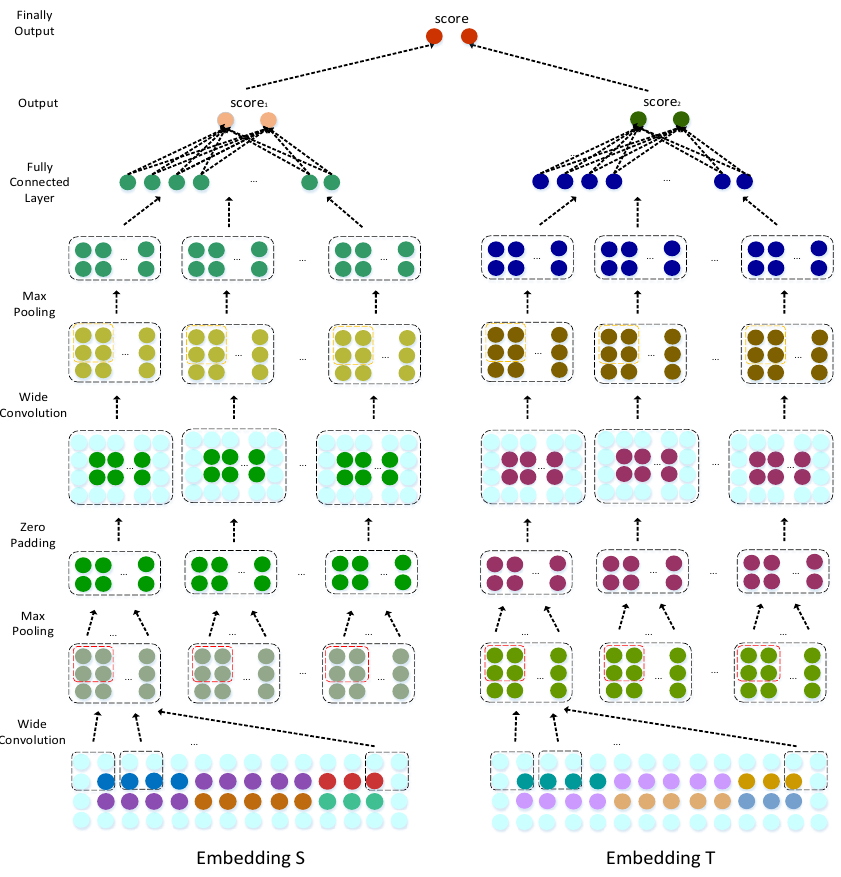
Figure 5. lncRNA–disease association prediction framework based on a dual CNN.